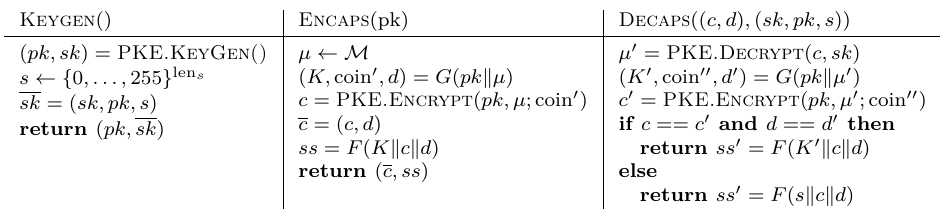
Figure 2: IND-CCA transform QFO 6⊥ and hash functions F and G [PAA +